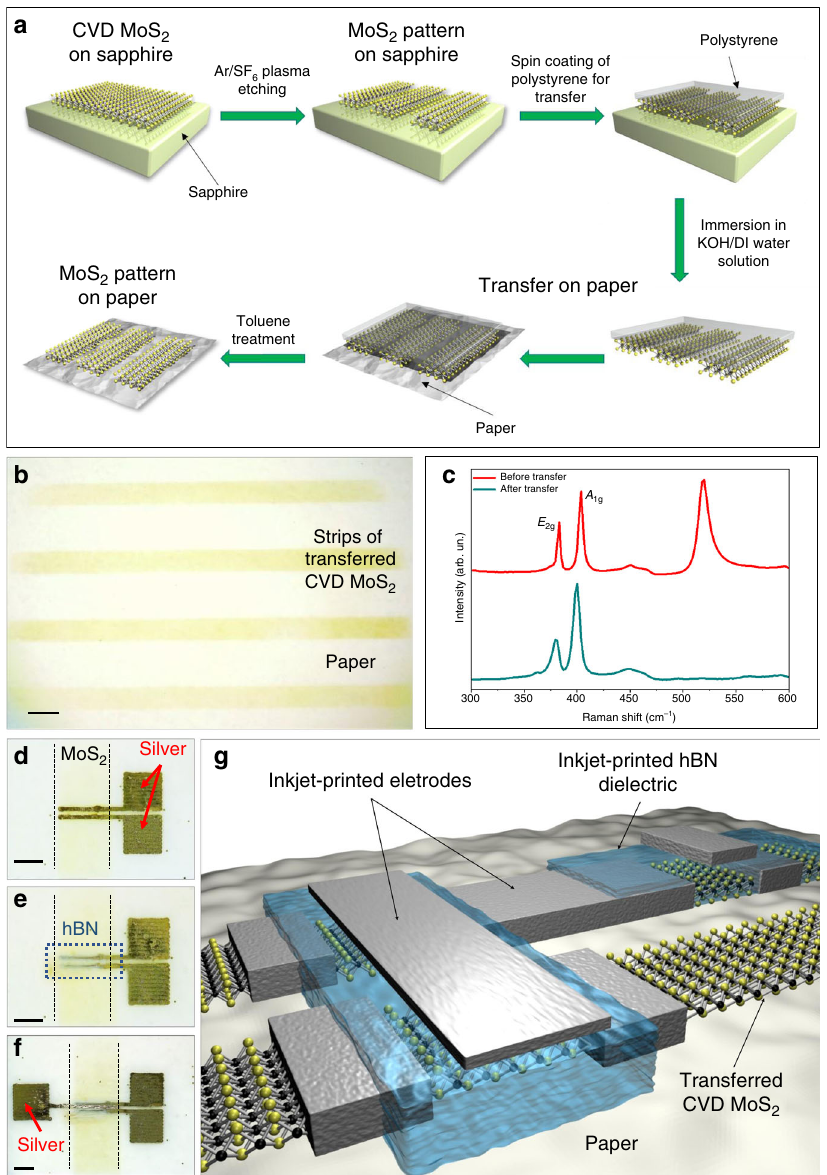
Fig. 1 Transferring scheme of MoS 2 channel stripes and fabrication process of MoS 2 FETs. a Schematic representation of the patterning and transferring procedure employed to obtain MoS 2 strips on paper. b Optical micrograph showing the transferred MoS 2 strips on paper. The scale bar corresponds to 1 mm. c Raman spectra acquired on the as-grown MoS 2 layer on rigid substrate (red line) and after MoS 2 transfer to paper (cyan line). d – f Fabrication steps of the inkjet-printed transistors on paper: d Inkjet-printing of silver source and drain contacts. e Inkjet-printing of the hBN dielectric layer (de fi ned by the blue-dotted frame). f Inkjet printing of silver top-gate contact. The scale bars in d – f correspond to 250 μ m. g Sketch showing an inkjet-printed circuit on paper with CVD-grown MoS 2